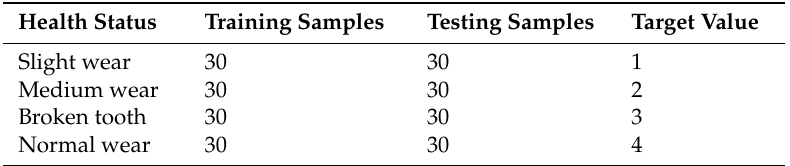
Table 6. Description of the gearbox datasets.